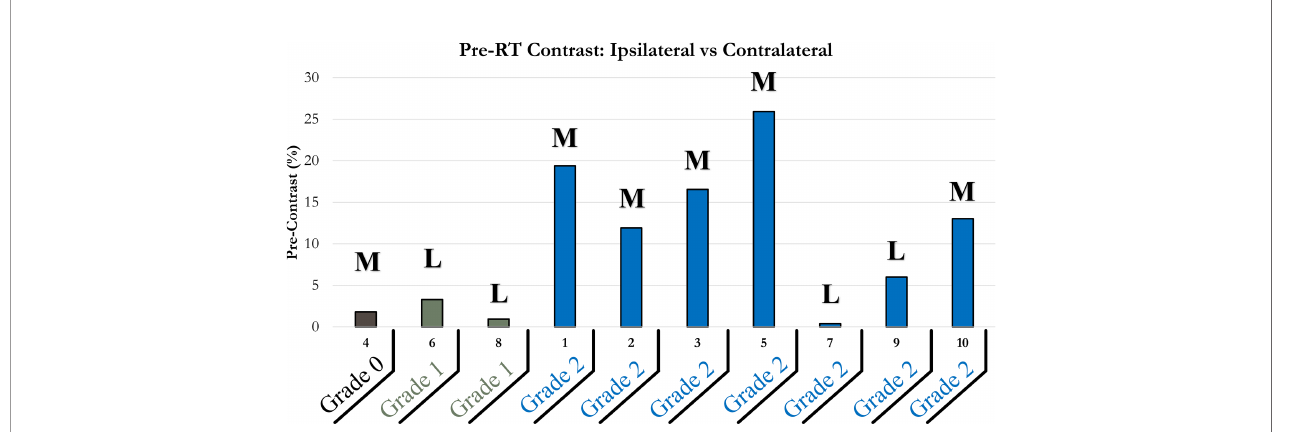
FIGURE 5 | Bar plot of pre-RT StO 2 contrast of ipsilateral and contralateral chest wall. Patients were grouped horizontally based on the maximum RD grading experienced during their RT; 0 (brown), 1 (green), 2 (blue). Bolded letters included above bars indicate mastectomy (M) or lumpectomy (L) surgical procedures performed prior